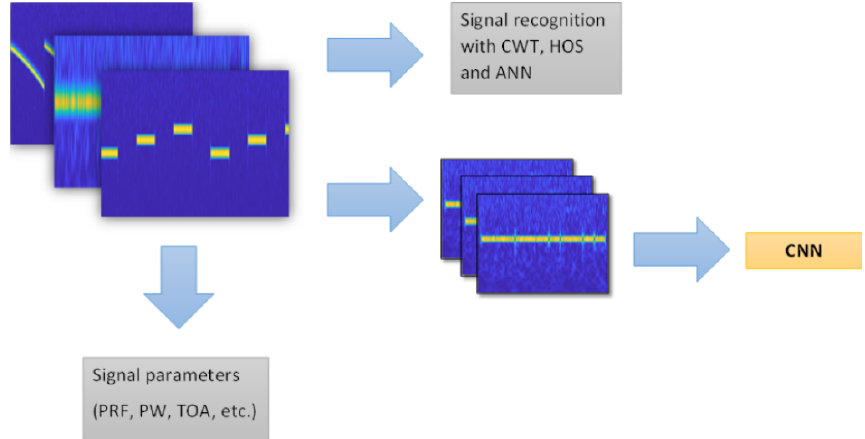
Figure 19. Proposal to use CWT coefficients with other methods used in signal